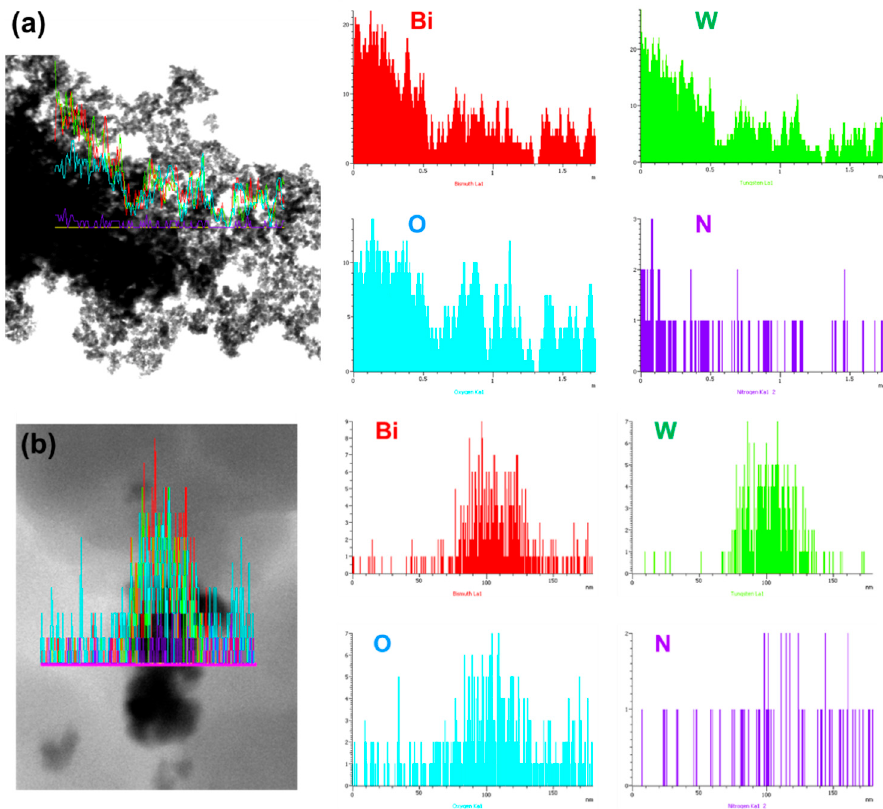
Figure 3. Transmission electron microscopy (TEM) image and energy-dispersive X-ray (EDX) spectrum of line scan of ( a ) G/BWP/PDA ( b ) G/PDA/BWNp.